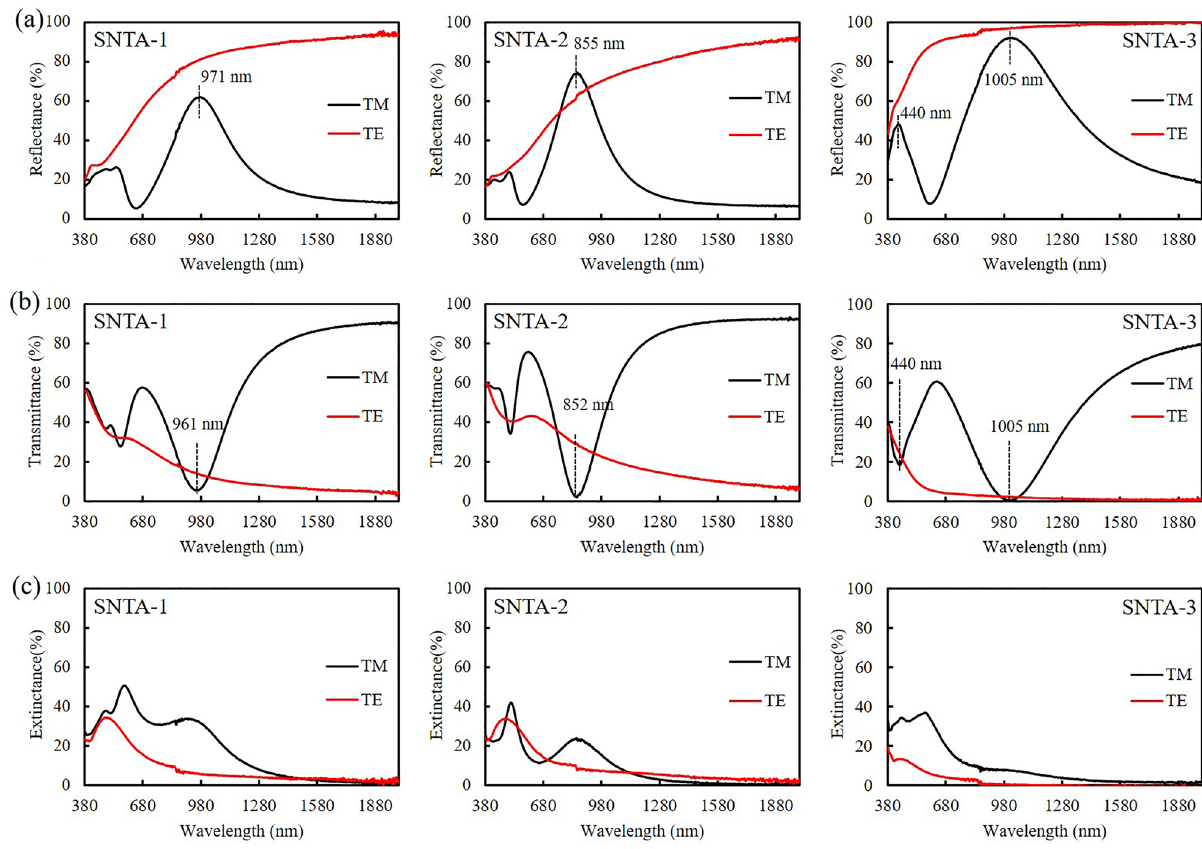
Figure 3. TM and TE polarized spectra of ( a ) reflectance (R), ( b ) transmittance (T) and ( c ) extinctance (E) of each sample.